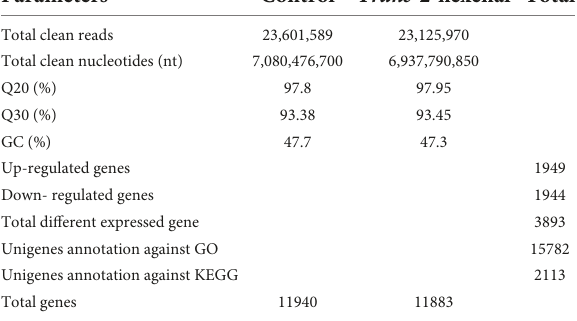
TABLE 2 Summary data of reads in control (CK) and ( E )-2-hexenal-treated B. cinerea mycelia